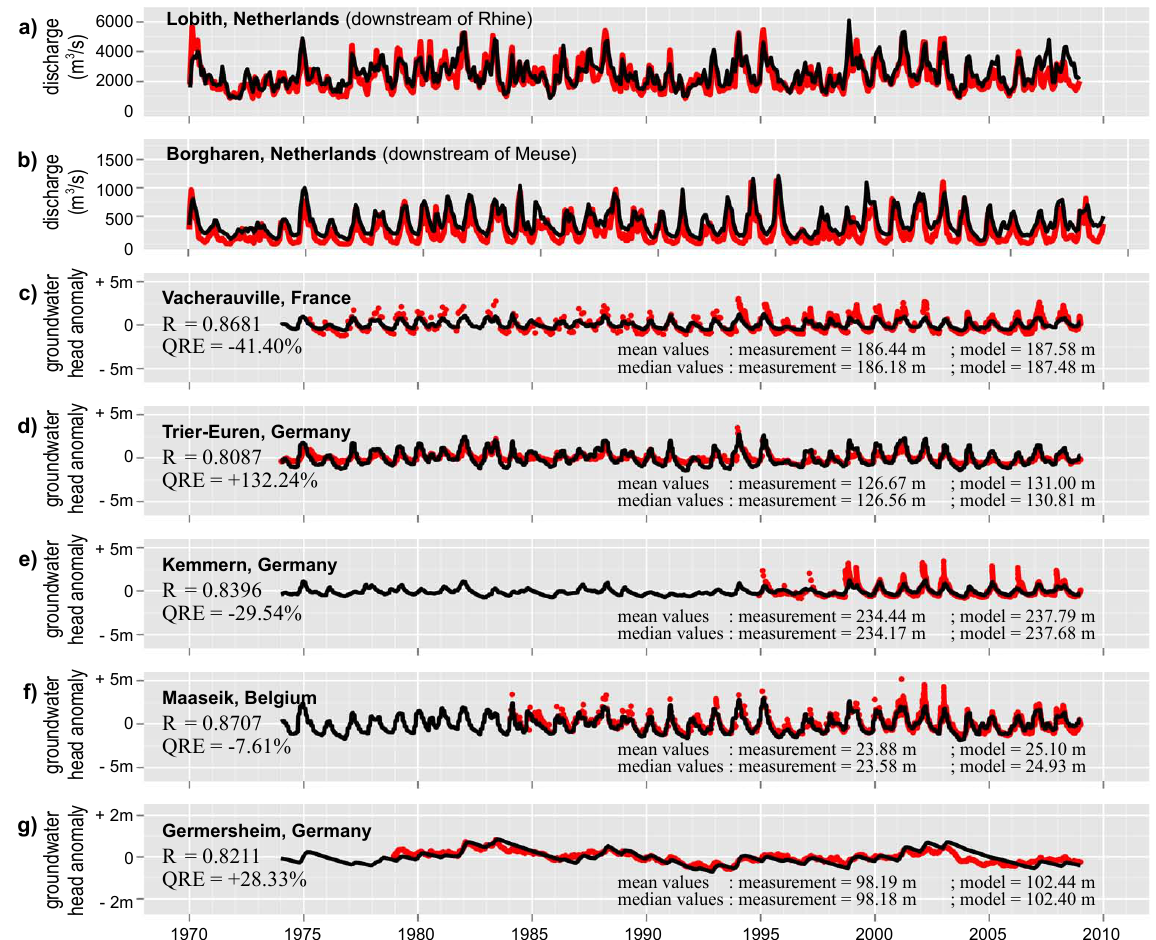
Fig. 5. The comparison between measurement data (red) and model output (black): (a) the discharge in Lobith, located downstream of the Rhine. (b) The discharge in Borgharen, located downstream of Meuse. (c, d, e, f, and g) Groundwater head anomaly comparisons based on the reference scenario A01.0 B01.0 at several locations indicated in Fig.